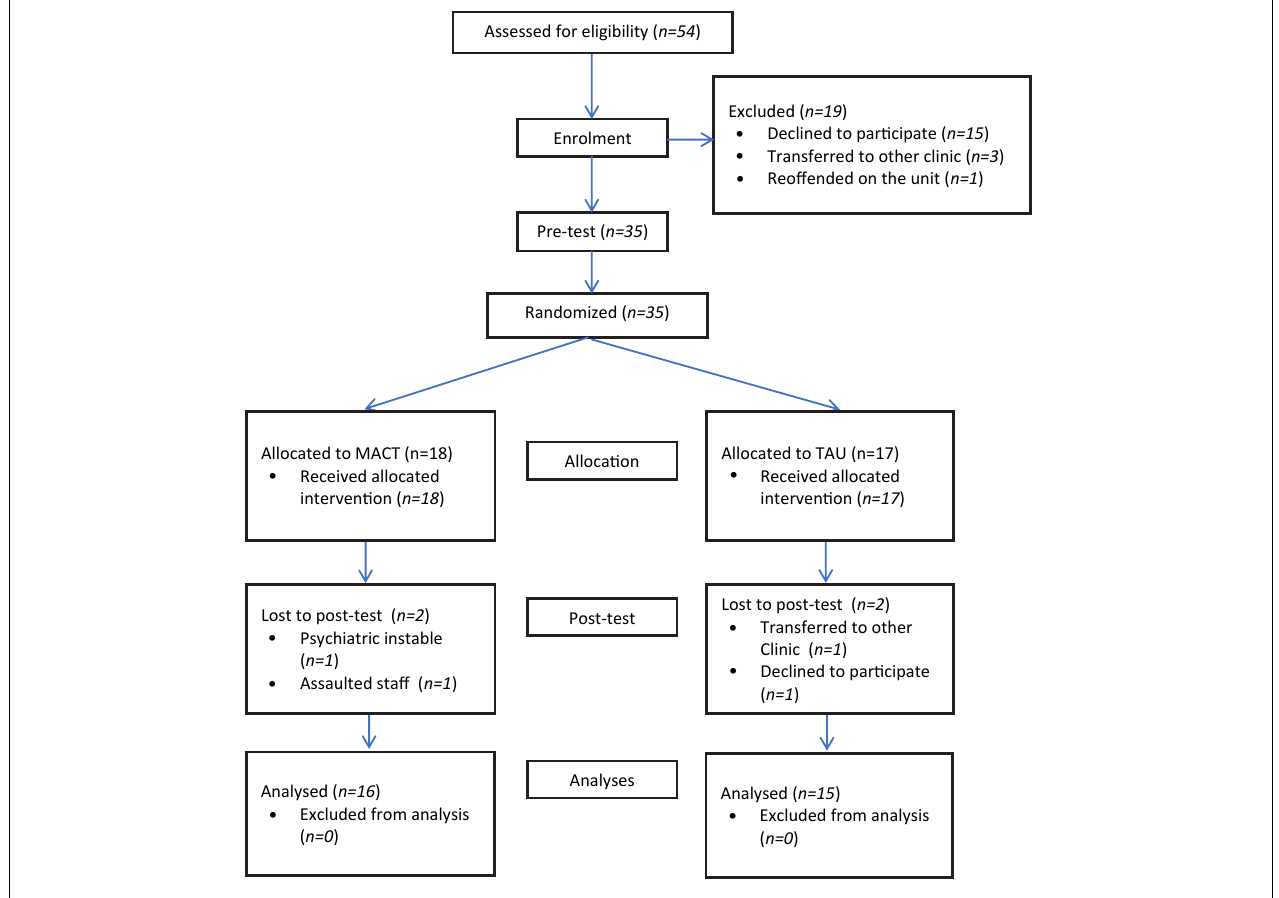
FIGURE 1 | Flow chart of